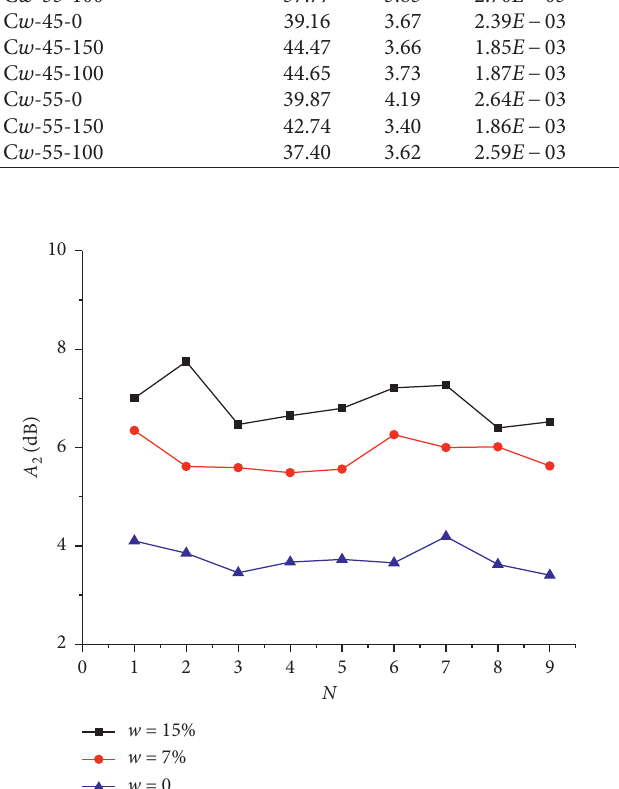
Figure 7: The effect of corrosion rate on the value of A